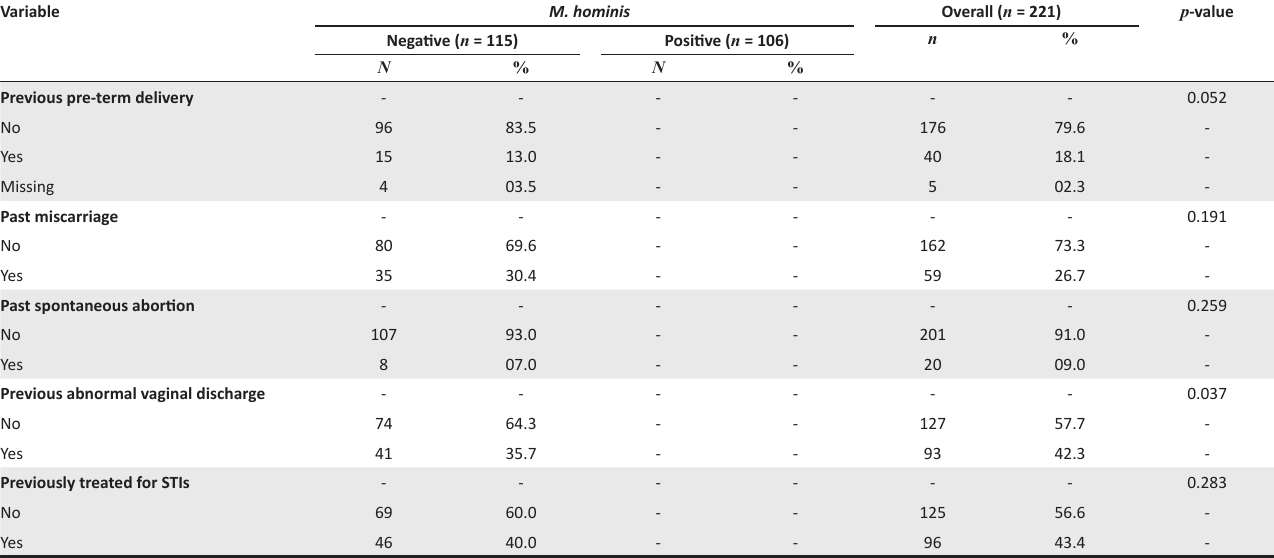
TABLE 1b (Continues...): Characteristics of the study population by Mycoplasma hominis status. Variable